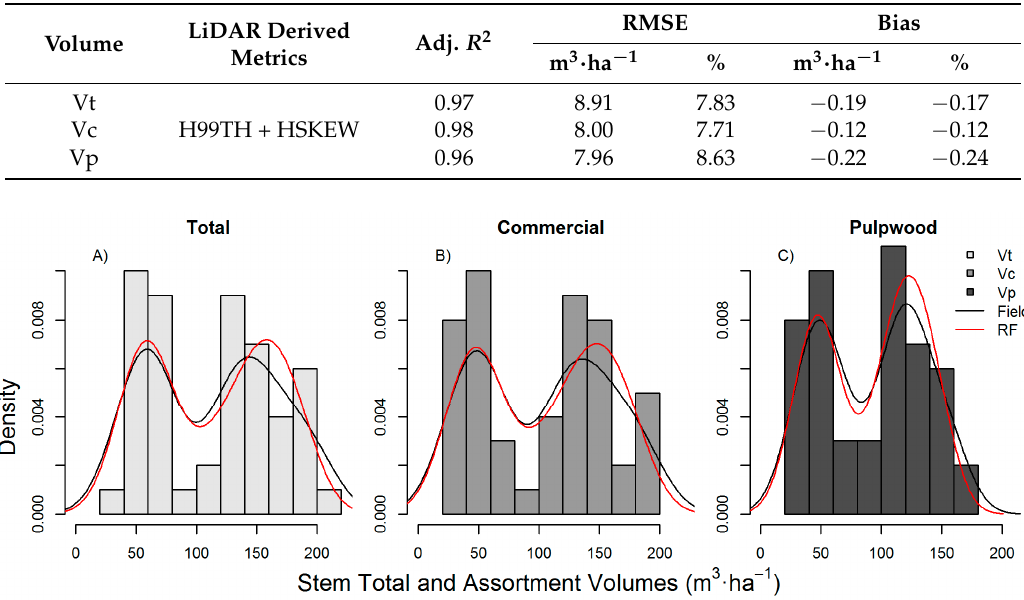
Figure 4. Distribution of observed (black line) and predicted (red line) s tem volume from RF. The gray histograms is based from field data. ( A ) Total volume (Vt) ( B ) Commercial volume (Vc) and ( C ) Pulpwood volume (Vp).